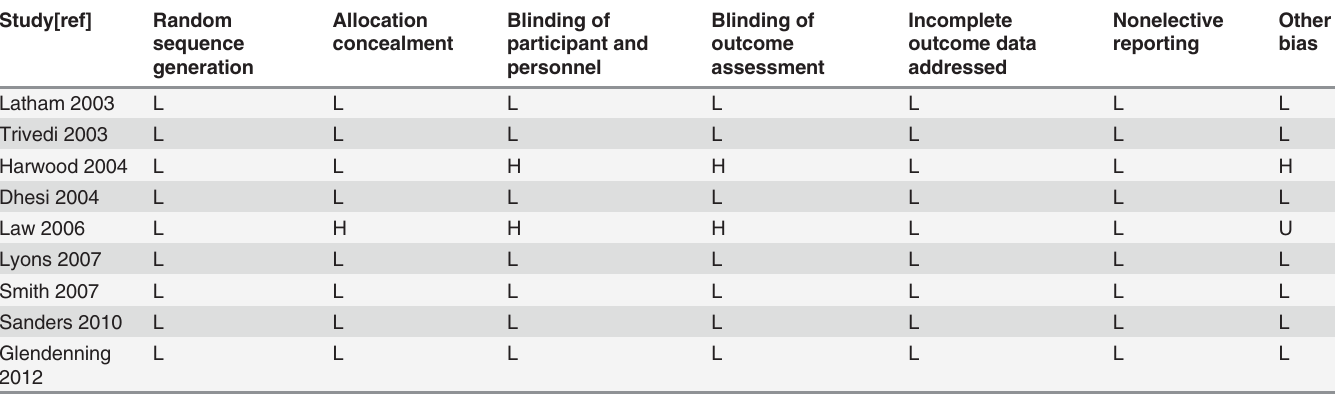
Table 2. Quality assessment of the included